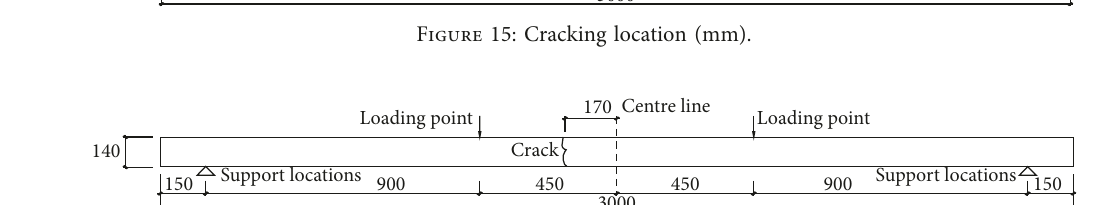
Figure 16: Crack location (mm).